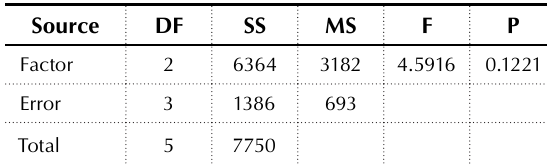
Table 12. ANOVA test